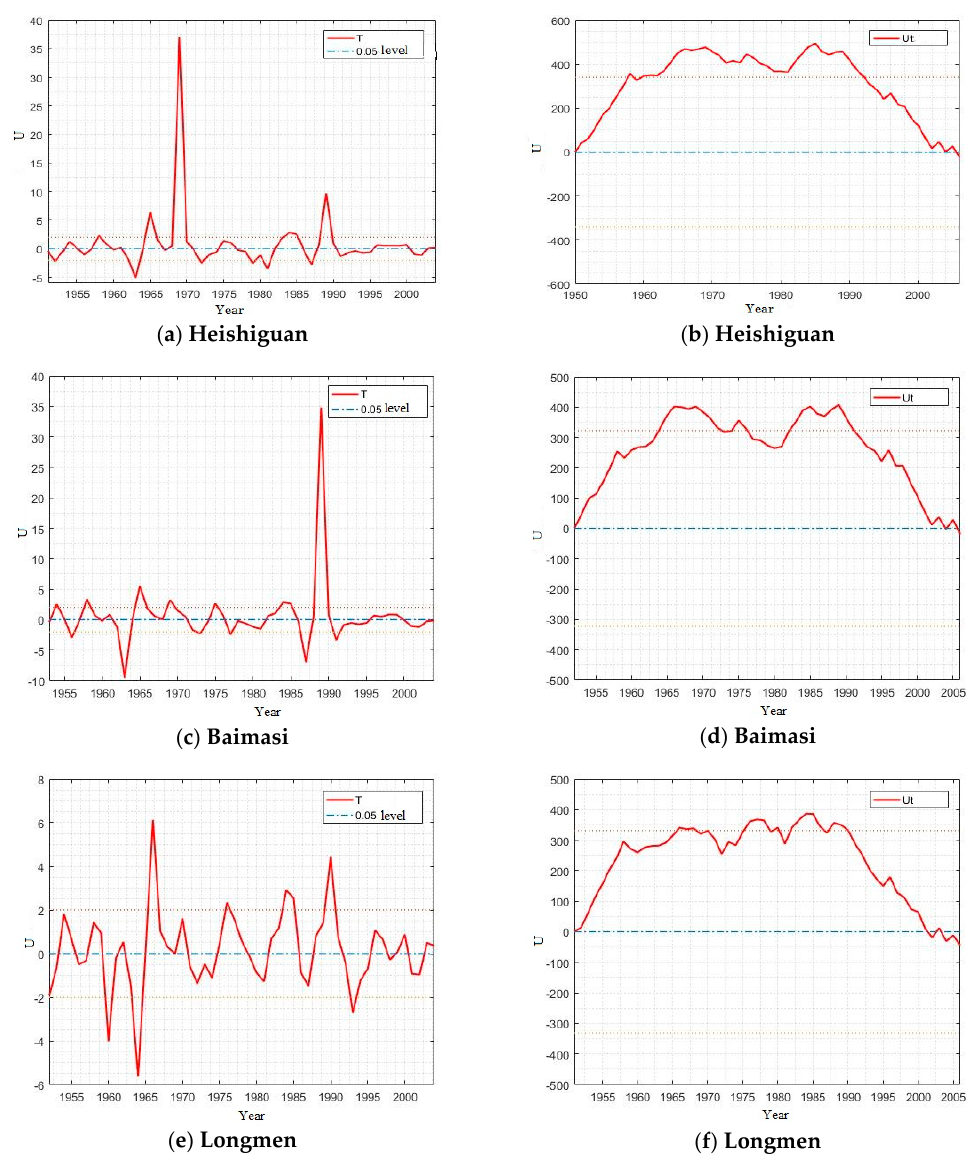
Figure 3. Jumping of annual maximum discharge sequence in Heishiguan, Baimasi and Longmen (( a , c , e ) are the sliding t -tests; ( b , d , f ) are Pettitt tests).